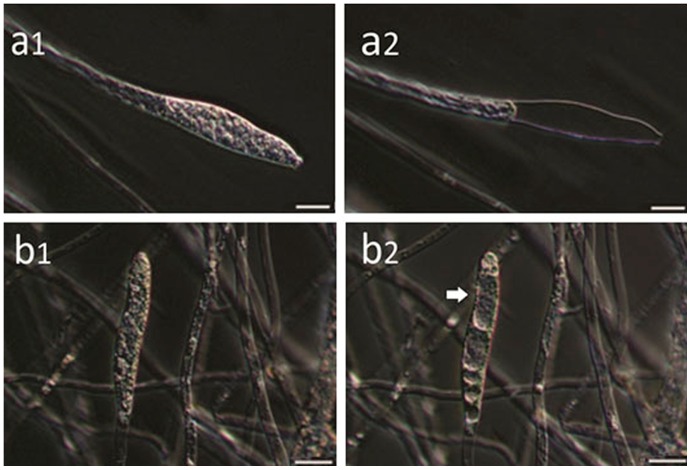

In vitro effect of boric acid on the development of Saprolegnia zoosporangia.
Saprolegnia zoosporangia in the non-treated control before (a1) and after (a2) spore release. Saprolegnia zoosporangia before (b1) and after 24 hours exposure to boric acid treatment (b2). Notice the degenerative changes within the zoosporangia and absence of spore production and release (b2; arrow).